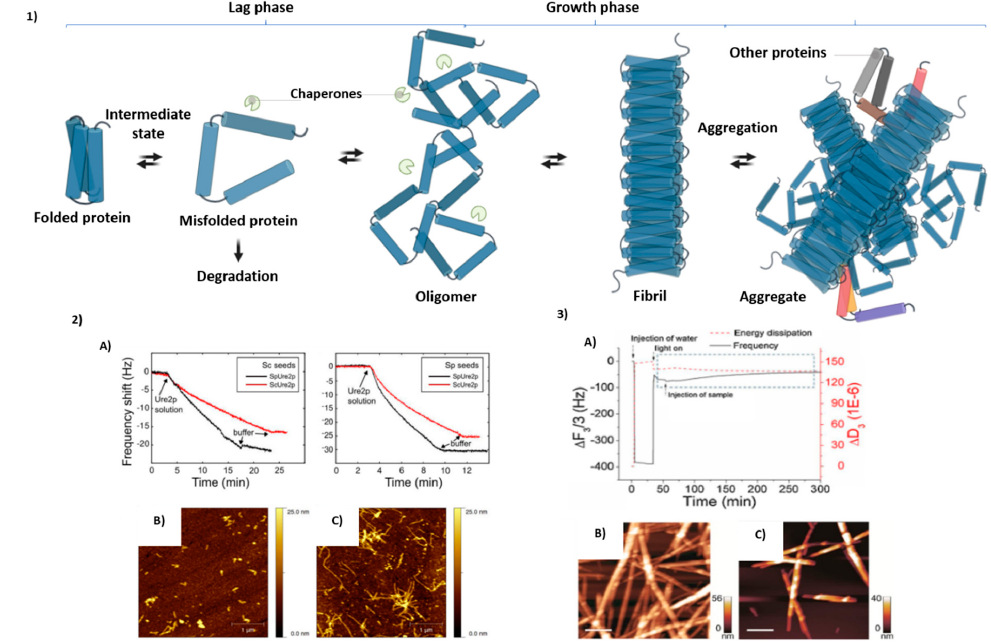
Figure 3. ( 1 ) Mechanism of amyloid formation proposed by Stroo et al. [103]. Misfolded protein